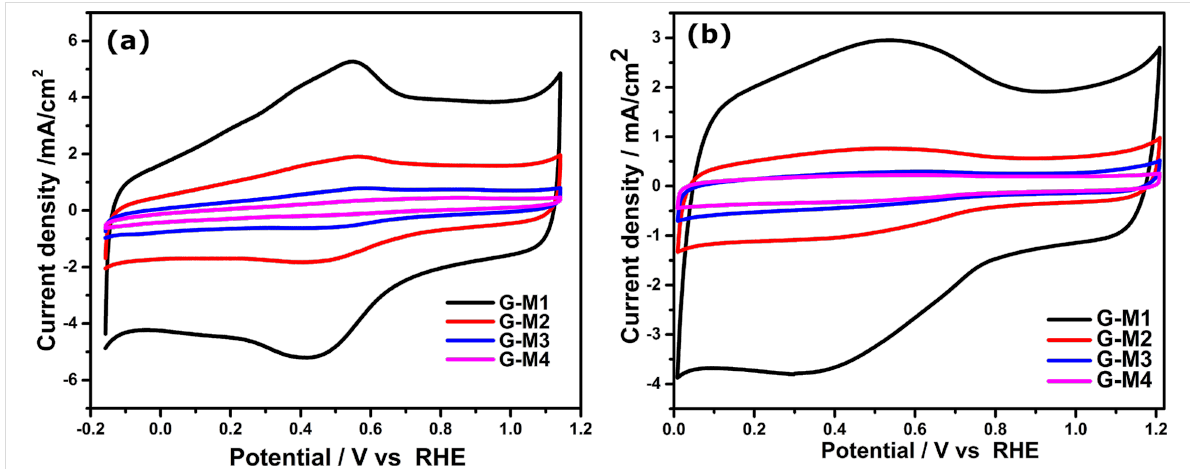
Figure 2: The CV profiles of different EEG samples in (a) acidic (0.5 M H 2 SO 4 ) and (b) alkaline (0.1 M KOH) electrolyte at 100 mV/s scan rate. The CV with low scan rate (5 mV/s) is shown in Supporting Information File 1, Figure S4a. The current densities are calculated using the geometrical area.